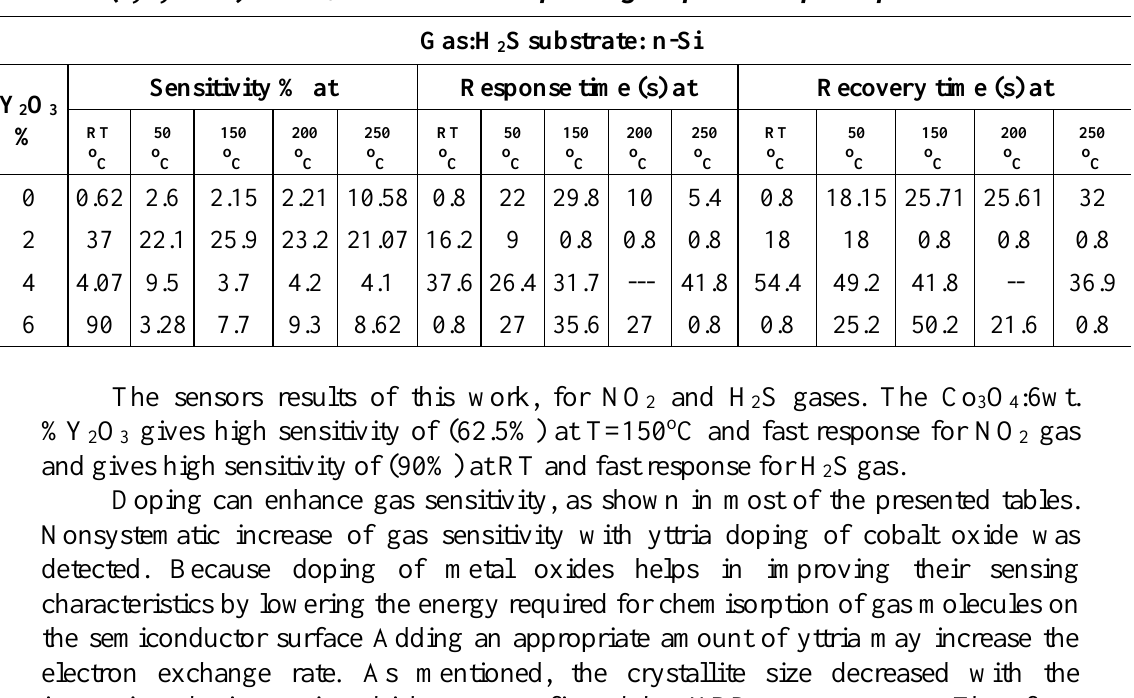
O and doped with 3 4 S. 2